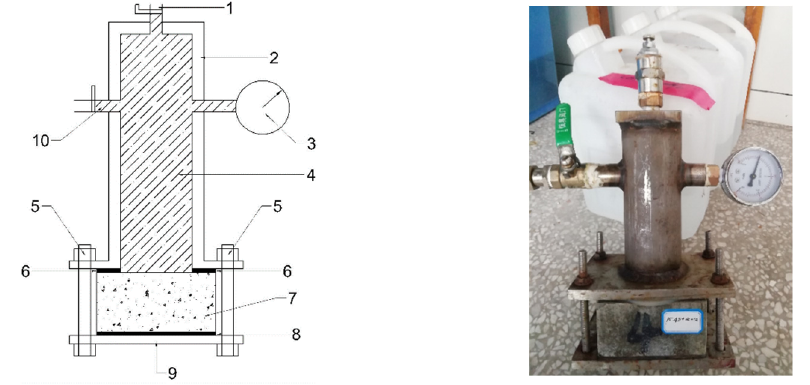
Figure 2. Schematic of the hydrostatic device and test pattern. 1—air evacuation valve; 2—hydrostatic device; 3—hydrostatic pressure indicator; 4—source solution cavity; 5—bolts; 6—hydro elastic rubber ring; 7—experimental specimen; 8—rubber gasket; 9—steel plate; 10—one-way refueling valve(connect the diffusion source solution).